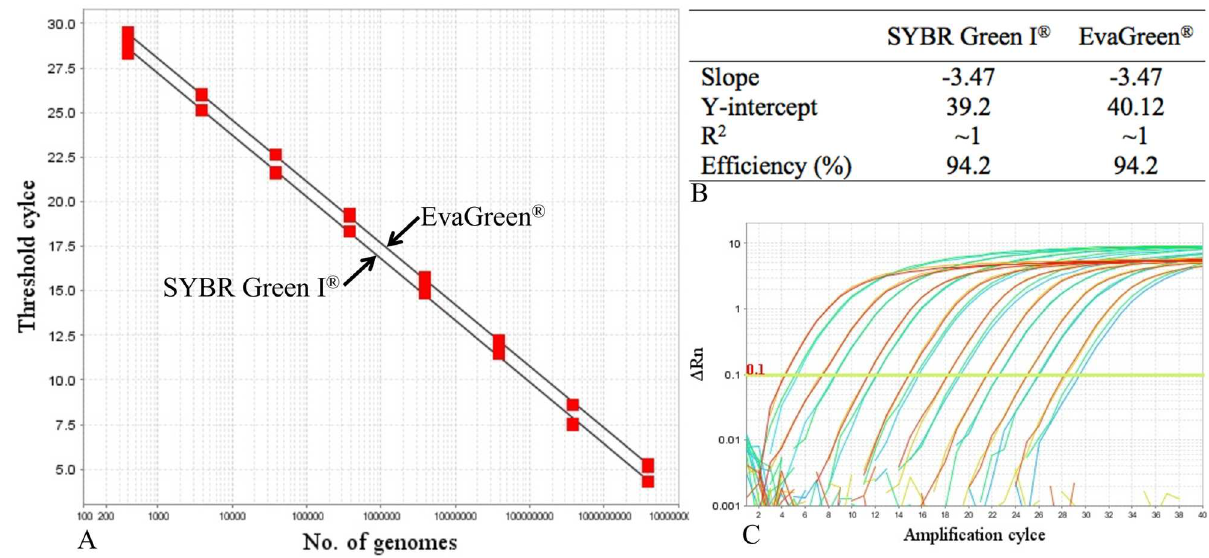
Fig 1. Performanceof SYBR Green I and EvaGreen detection chemistries during qPCR assays. (A) Standardcurves generatedfrom amplification of serially diluted L . lactis phageP220 genome detected with the corresponding chemistries; (B) the corresponding performance parameters; and (C) amplification plots detected with SYBR Green I (brown) and EvaGreen (green).